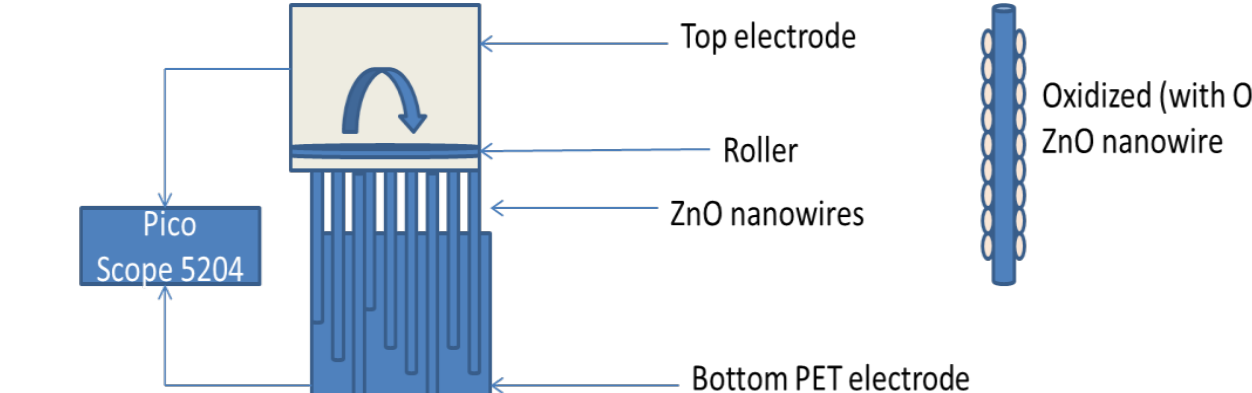
Figure 1. Schematic diagram of ZnO based VING and oxidized ZnO nanowire.